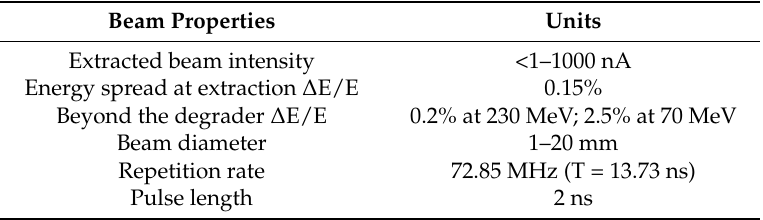
Table 1. Properties of extracted beam from COMET